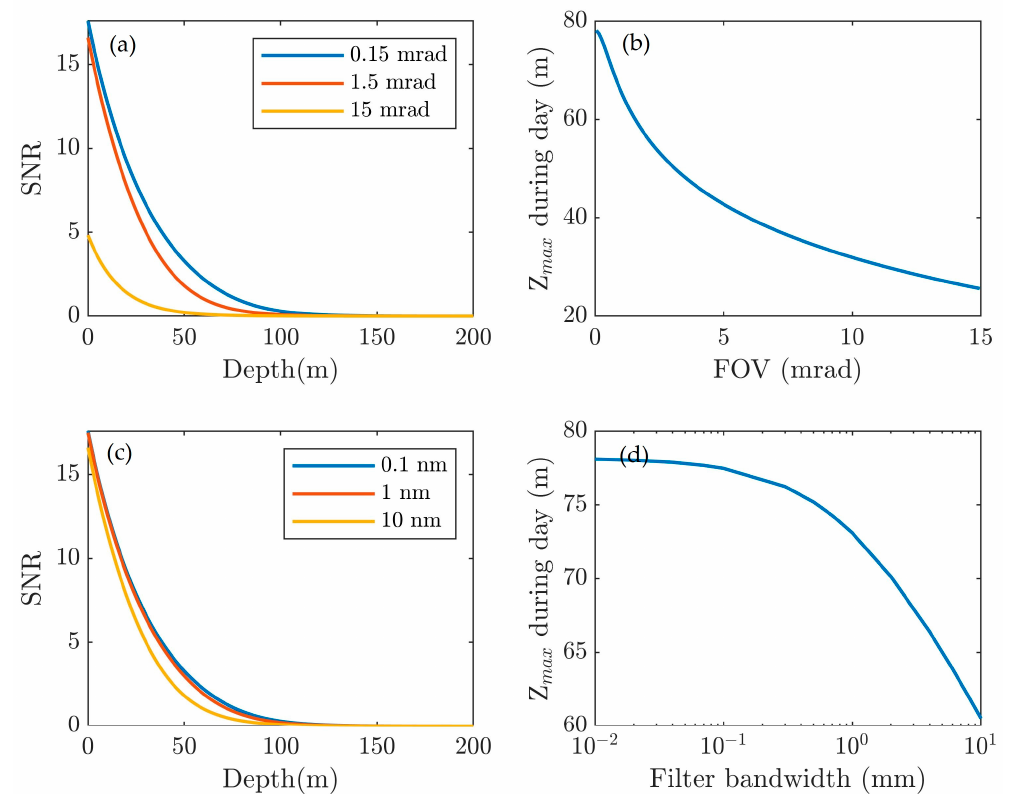
Figure 18. SNR during the day for spaceborne lidar with different FOV for a specific 0.1-nm filter bandwidth ( a ), different filter bandwidth for a specific 0.15-mrad FOV ( c ), the maximum detectable depth versus FOVs ( b ), and filter bandwidths ( d ).